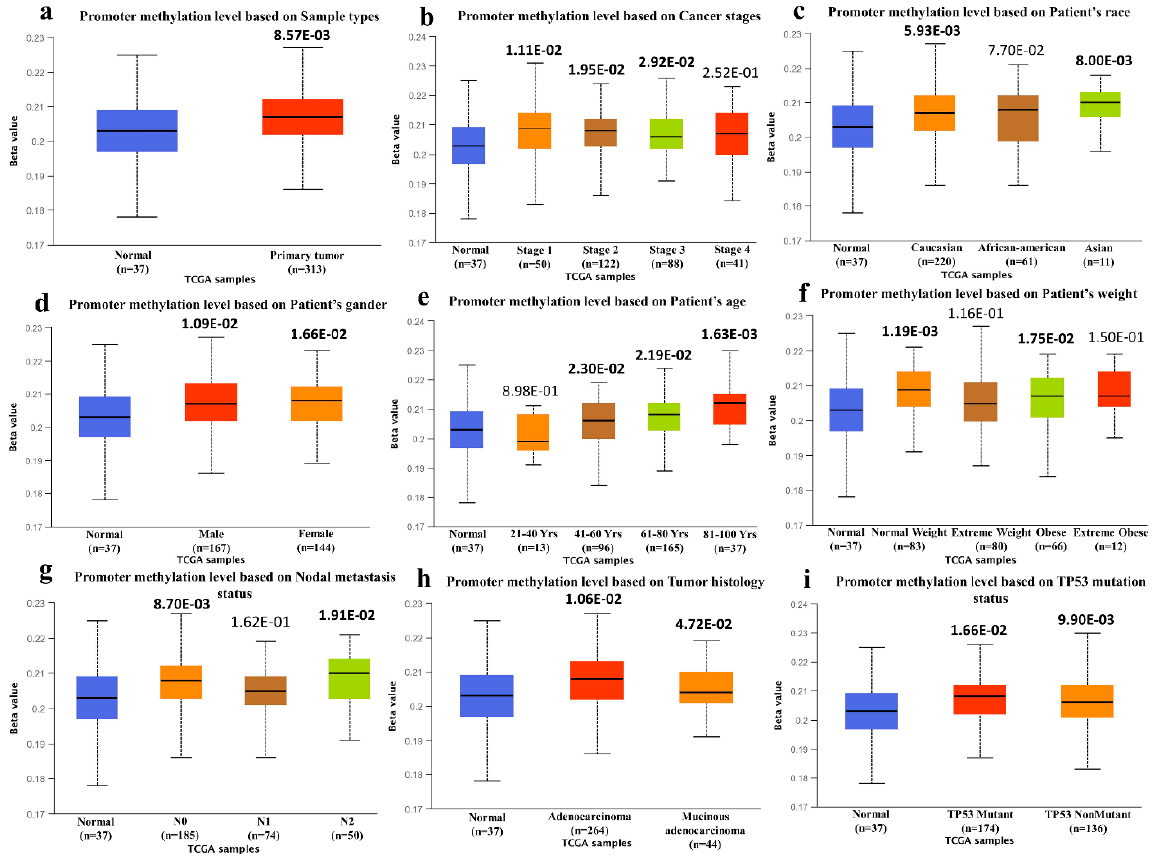
Figure 4. SYK gene promoter methylation level in TCGA COAD based on different variables by using the UALCAN database. ( a ) The promoter methylation level of SYK in COAD is based on sample types. ( b ) The promoter methylation level of SYK in COAD is based on individual cancer stages. ( c ) The promoter methylation level of SYK in COAD is based on the patient’s race. ( d ) The promoter methylation level of SYK in COAD is based on the patient’s gender. ( e ) The promoter methylation level of SYK in COAD is based on the patient’s age. ( f ) The promoter methylation level of SYK in COAD is based on the patient’s weight. ( g ) The promoter methylation level of SYK in COAD is based on the nodal metastasis status. ( h ) Promoter methylation level of SYK in COAD is based on the tumor histology. ( i ) Promoter methylation level of SYK in COAD based on the TP53 mutation status. Based on UALCAN, the beta value indicates the level of DNA methylation, ranging from 0 (unmethylated) to 1 (fully methylated). The bold P -value denotes the statistical significance.